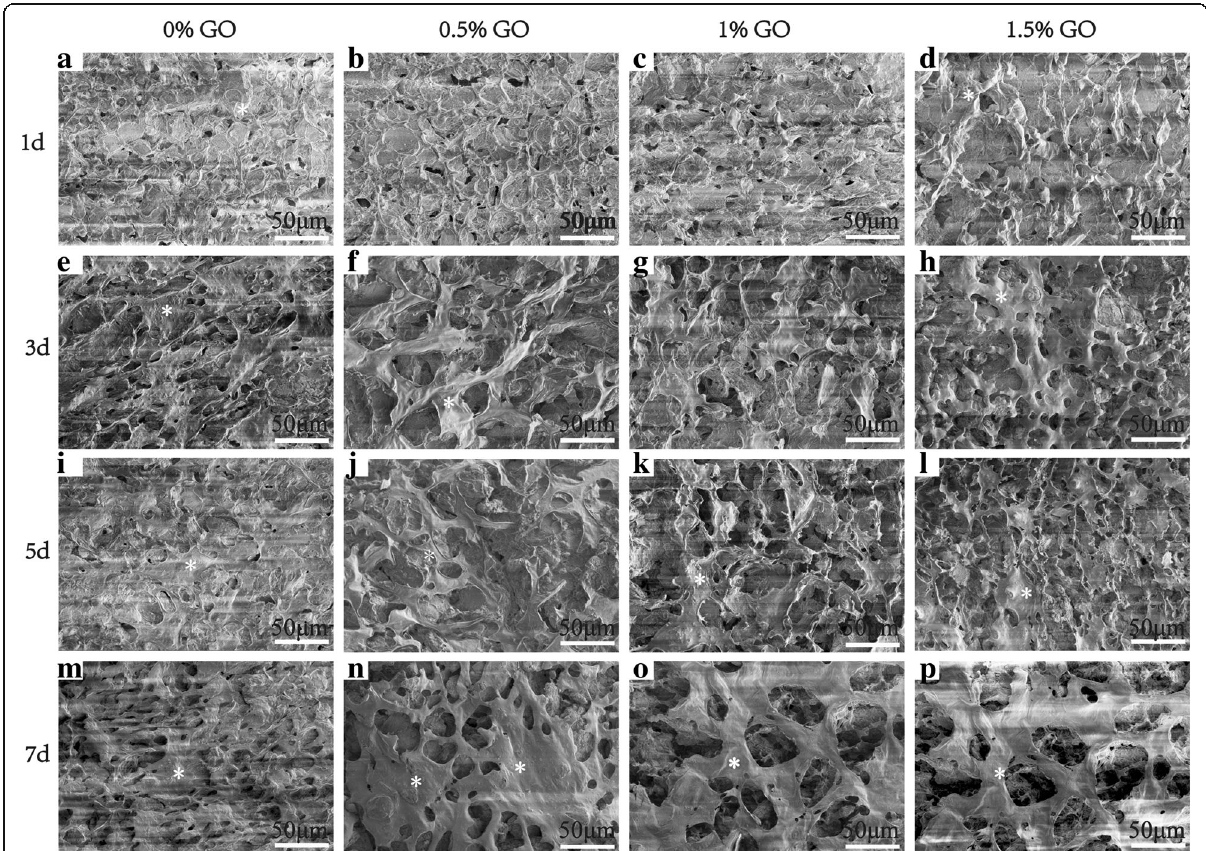
Fig. 6 a – p SEM images of MC3T3-E1 cells cultured on four different scaffolds for 1, 3, 5, and 7 days. Scale bars are 50 μ m in all images.The white asterisk represents the MC3T3-E1 osteoblast cells